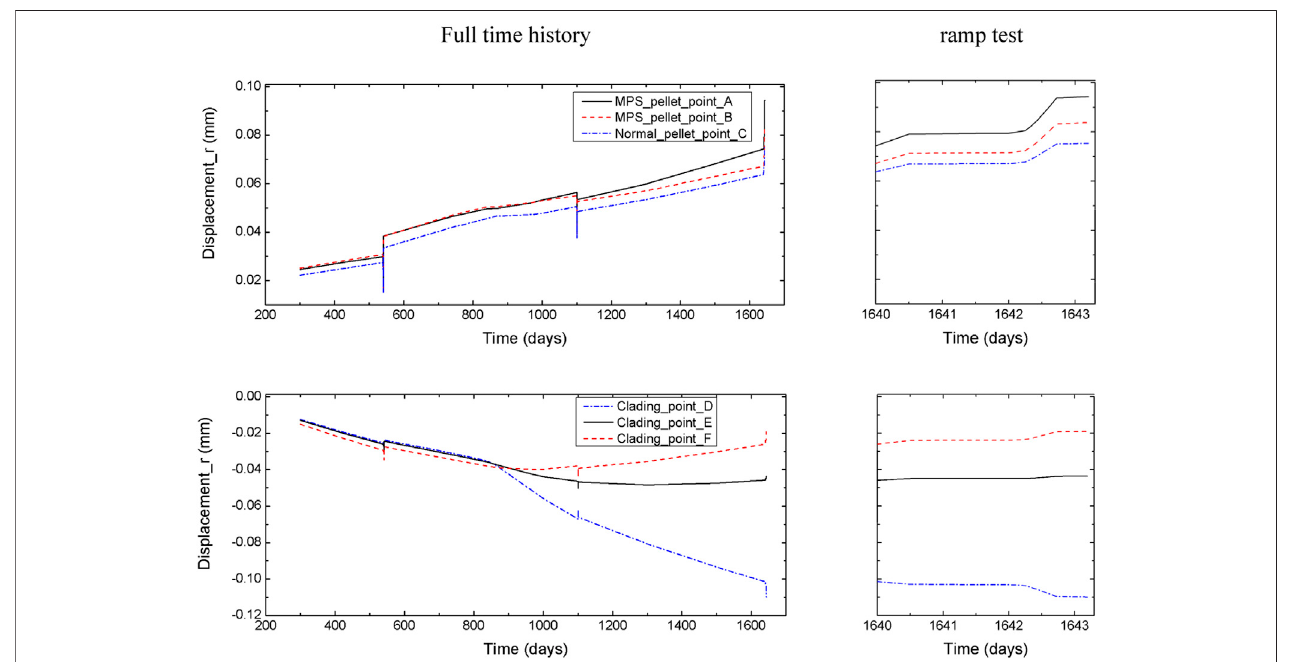
FIGURE 13 | Radial displacement distribution in full irradiation history at pre-set points showing a comparative way with MPS defects and no defect pellet.